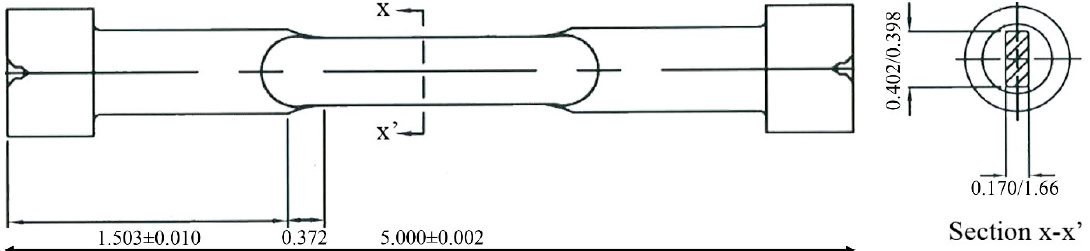
Figure 1. Sketch of Kb bar specimen. Dimensions in mm (printed with permission from Metcut Research).